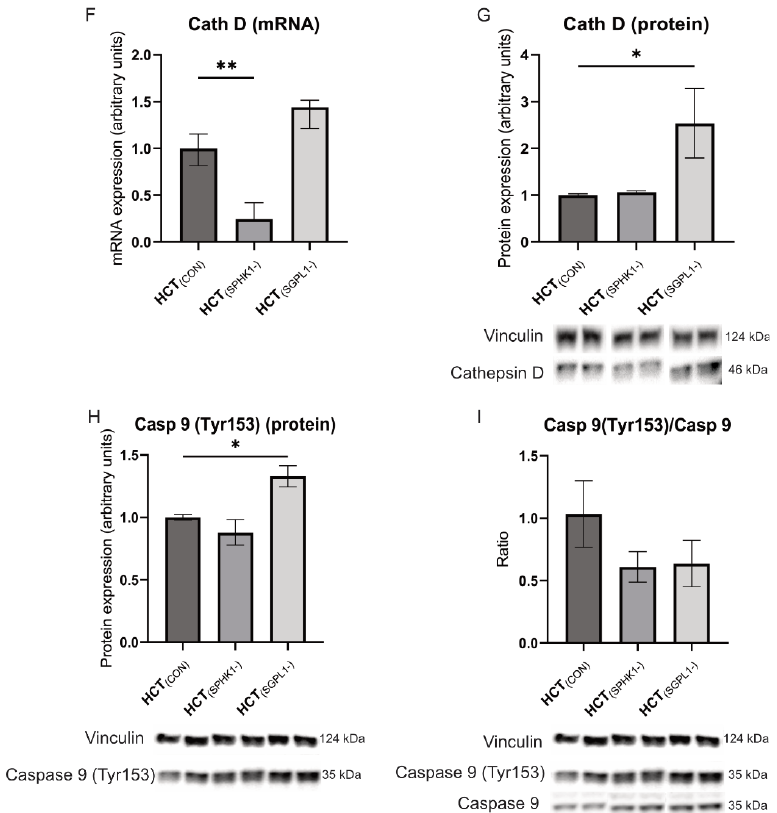
Figure 4. The impact of SPHK1 and SGPL1 gene silencing in human colorectal tumor HCT-116 cell line on the expression and phosphorylation state of initiator Caspase-9 (panels A , B , H , I ), executioner Caspase-3 (panels C – E ) and Cathepsin-D (panels F , G ). Two lower bands in Panel 4E show active (cleaved) Caspase-3. Protein bands from two independent representative WBs are presented below expression protein graphs. Values are control-normalized medians +/- interquartile ranges (n = 6 qPCR; n = 4 WB). * p < 0.05; ** p < 0.01 vs. control (HCT (CON) ).